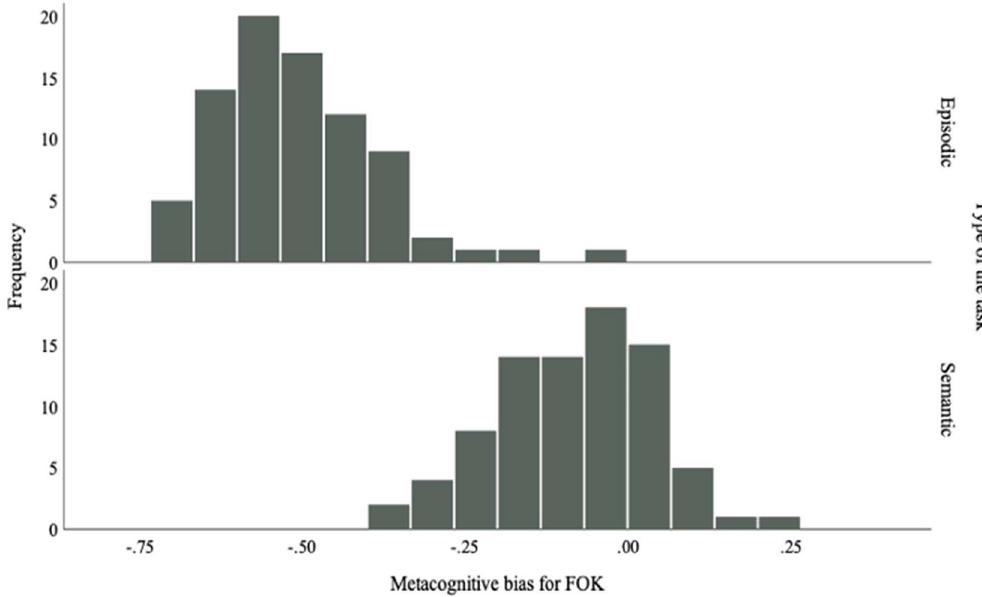
Figure 1. Metacognitive sensitivity during FOK phases of episodic and semantic memory